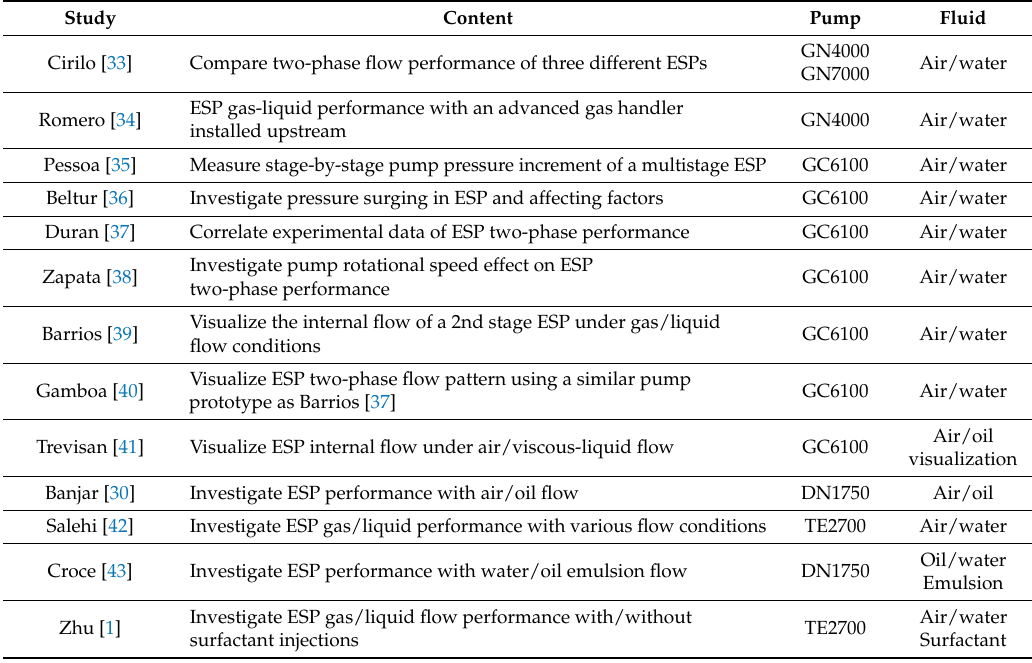
Table 7. Experimental studies on ESP two-phase performance conducted at